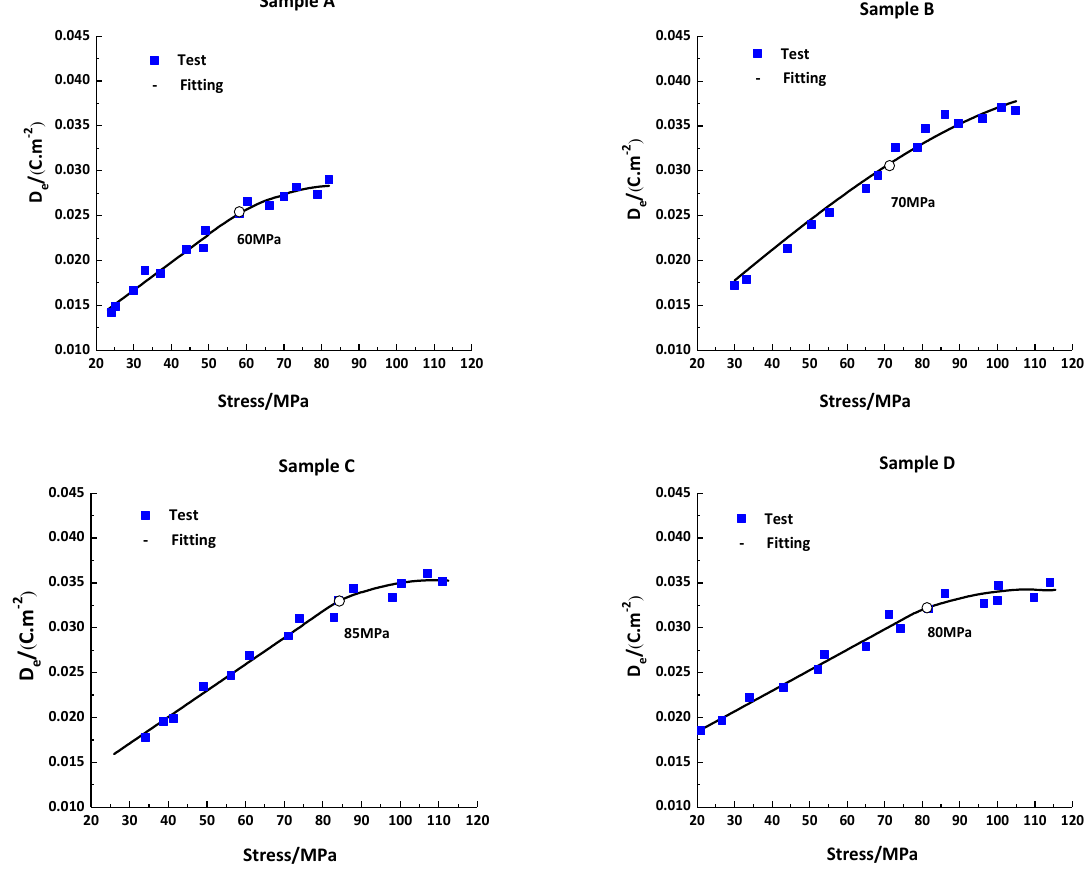
Figure 8. Dynamic sensitivity calibration curves of samples A, B, C, and D.